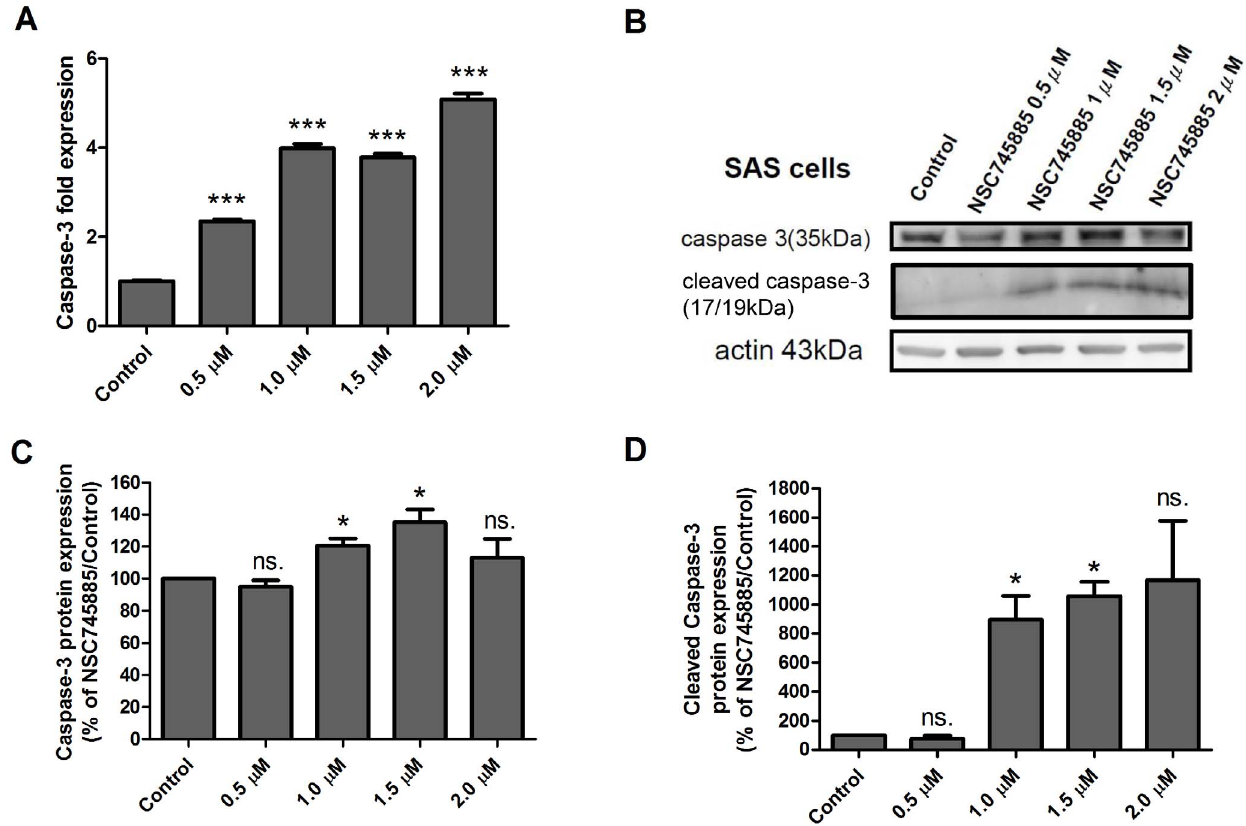
Figure 4. NSC745885 treatment enhanced the expression and activation of caspase-3 in SAS cells. (A) The relative RNA expression level of caspase-3 in SAS cell treated with indicated dosages of NSC745885 for 24 hours was evaluated using real-time RT-PCR. The expression of caspase-3 significantly increased with NSC745885 treatment in a dosage-dependent manner. (B) The caspase-3 and cleaved caspase-3 protein levels in the SAS cell treated with NSC745885 for 48 hours was quantified using western blot. (C) The results of the western blot in caspase-3 were evaluated in 3 independent experiments and normalized with b -actin (*, P , 0.05; **, P , 0.01; ***, P , 0.001; ns., non-significant). The protein level of caspase-3 was highest in 1.5 m M of NSC745885 treatment. (D) The results of the western blot in cleaved caspase-3 were evaluated in 3 independent experiments (*, P , 0.05; ns., non-significant).